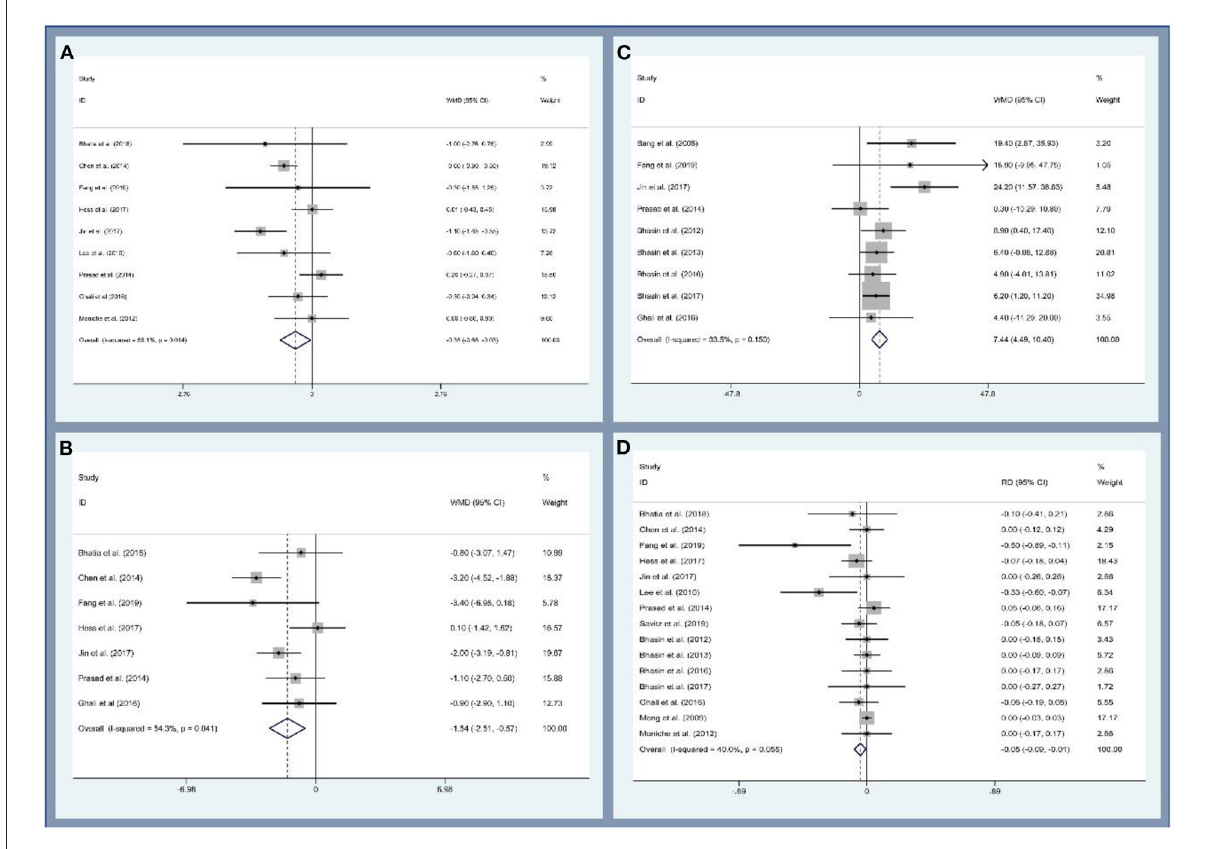
FIGURE3 Forest plot for meta-analysis of the modified Rankin Scale (mRS) (A) , National Institute of Health Stroke Scale (NIHSC) (B) , Barthel index (BI) (C) , and death rate (D)